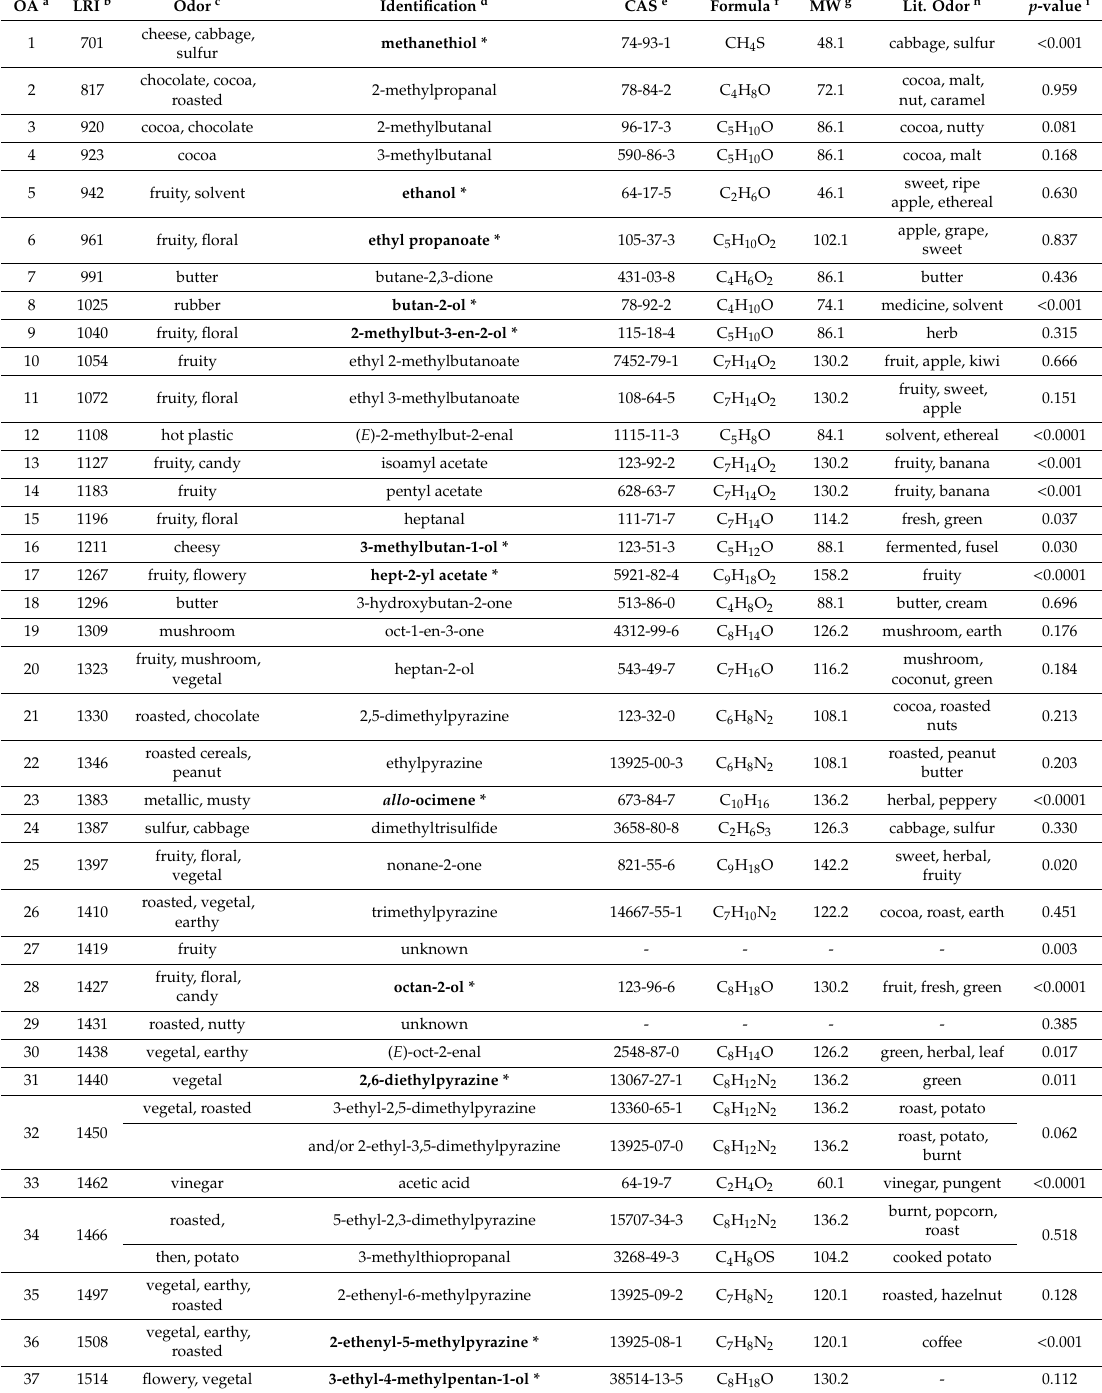
Table A1. Key aroma compounds in dark chocolate (12 samples) determined in a cDFA GC-O analysis Table 1; b LRI on DB-FFAP, as in Table 1; c Odor attributes given by the panel; d Identification (refer to Table 1); e Chemical Abstracts Service registry number; f Mass formula; g Molecular Weight; h Pertinent odor attributes found in the databases VCF [54] and The Good Scents Company (http: // www.thegoodscentscompany.com / ); i p -value of the Khi 2 test ( α = 0.05) obtained for the parametric test comparison of k proportions using the data of Table